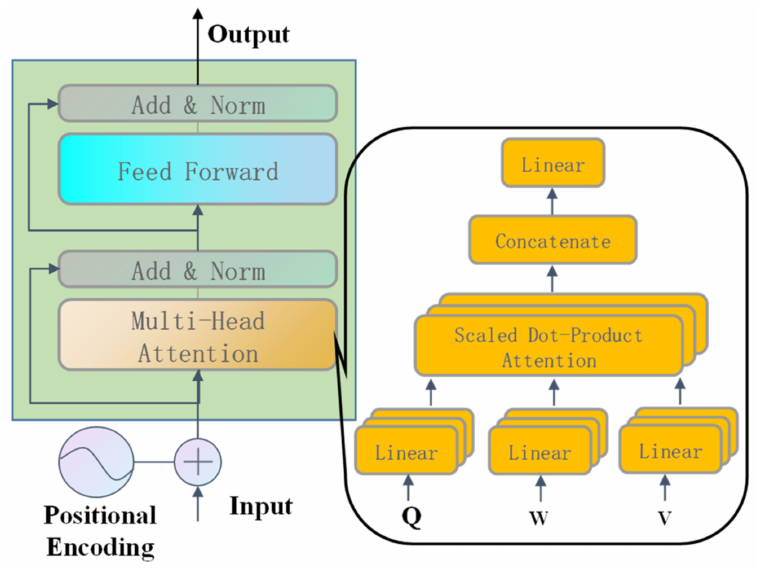
Figure 4. Structure of an